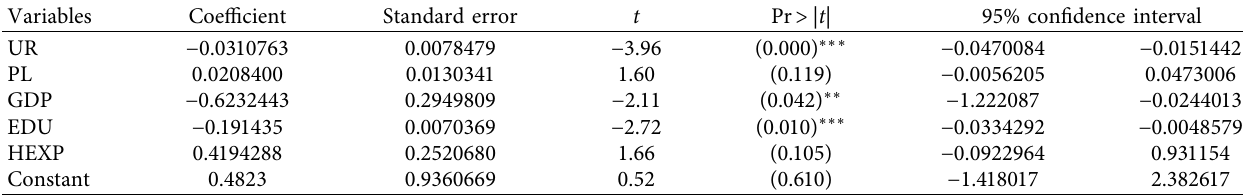
Table 2: Panel analysis regression